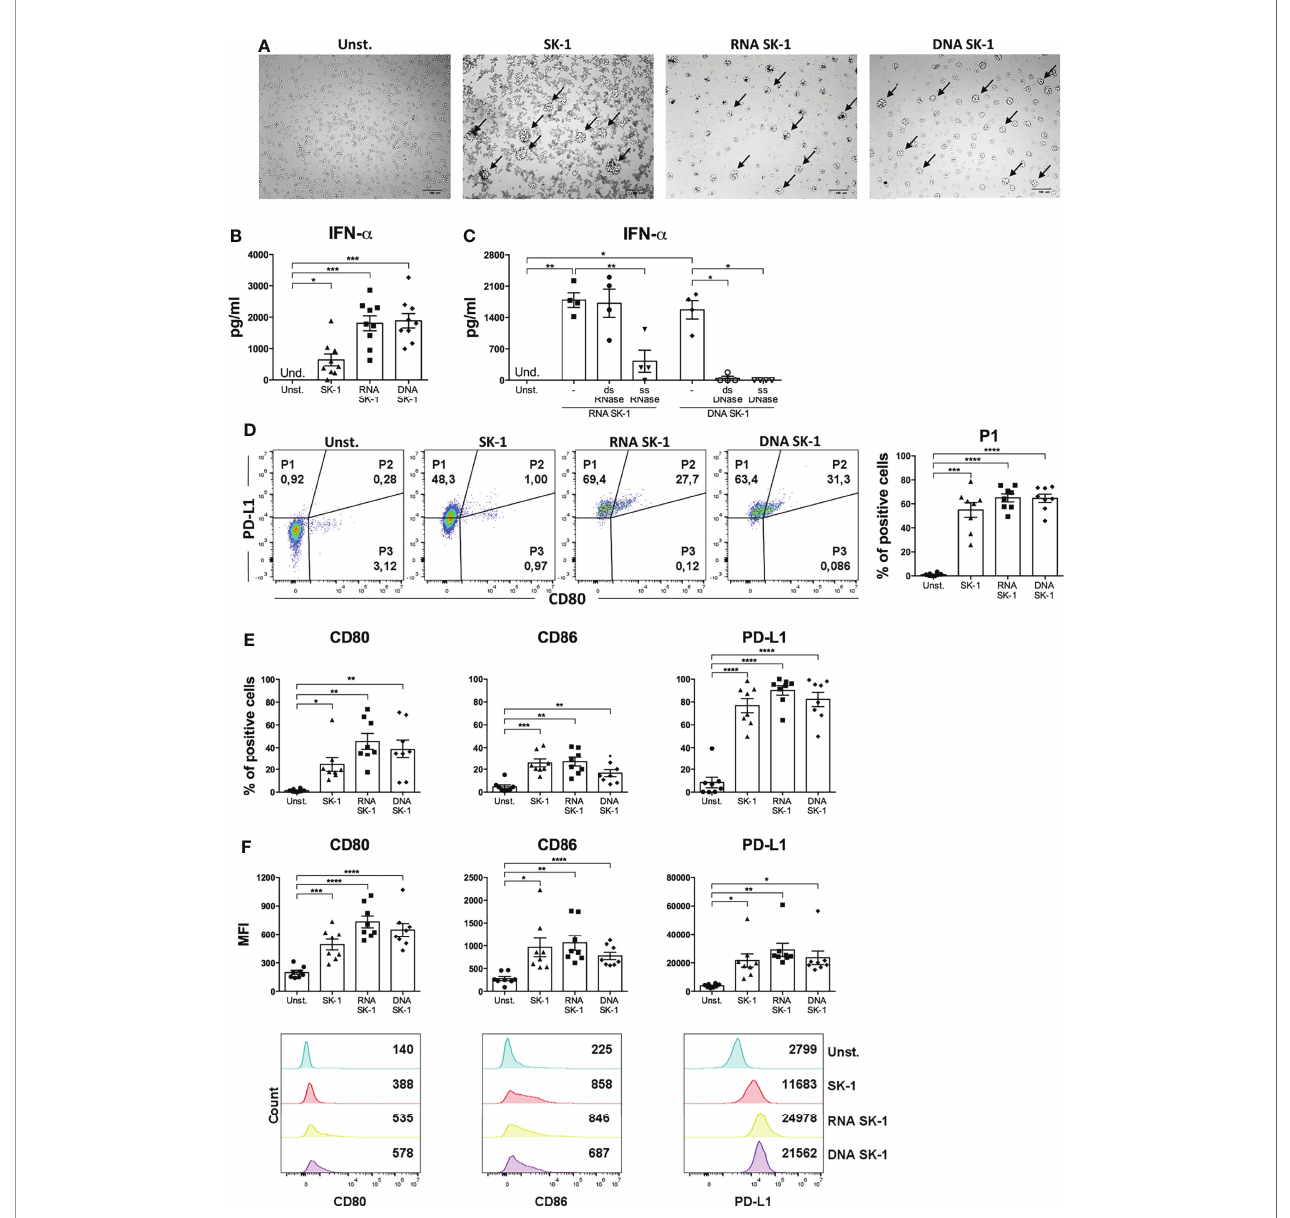
FIGURE 4 | RNA and DNA of SK-1 induce activation of human plasmacytoid dendritic cells (pDCs). Human pDCs puri fi ed from the peripheral blood of healthy donors were cultured for 48 h with RNA or DNA (0.2 m g) extracted from Saccharomyces cerevisiae SK-1 and pre-treated with Dotap (10 m l/ m g of nucleic acids) for 30 min at 37° C without stimulation (Unst.) and with the laboratory strain of Saccharomyces cerevisiae SK-1 at multiplicity of infection = 5 (SK-1/pDC). Photos taken with an optical microscope show the cell clusters formed by pDCs upon activation highlighted by arrows (A) . The pictures are representative offour experiments, each from a different donor. DNA and RNA were pre-treated with nucleases where indicated. The levels of IFN- a were measured in the culture supernatants by ELISA (B, C) . The percentage of the P1-pDC subpopulation was evaluated by fl ow cytometry (D) . The percentages and median fl uorescence intensity of costimulatory molecules CD80, CD86, and PD-L1 were analyzed by fl ow cytometry (E, F) . The graphs show the mean ± SEM of eight independent experiments, each from different donors. One-way ANOVA was used to compare different experimental conditions (*= p -value ≤ 0.05; **= p -value ≤ 0.01; ***= p -value ≤ 0.001; ****= p -value ≤